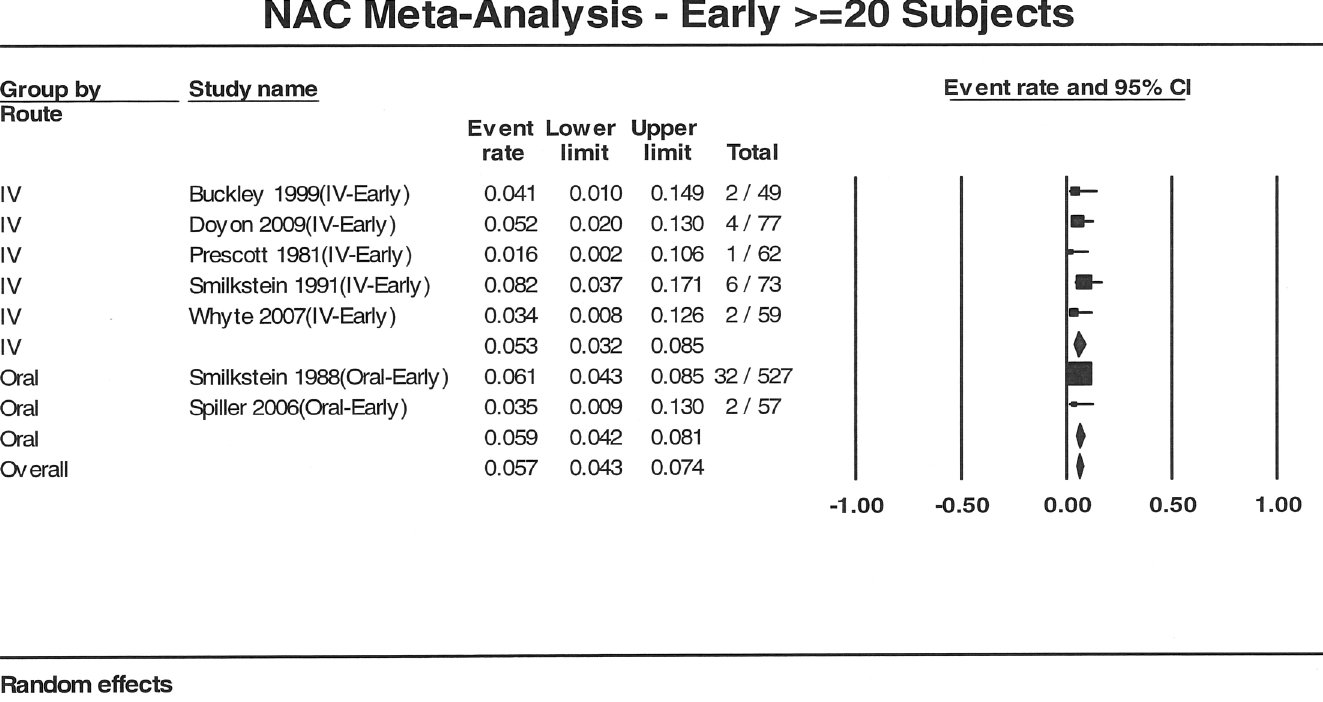
Figure 3. Forest plot showing proportion of patients with acetaminophen poisoning who developed hepatotoxicity for intravenous and oral acetylcysteine treatment when acetylcysteine was administered early (within 10 hours or as defined by